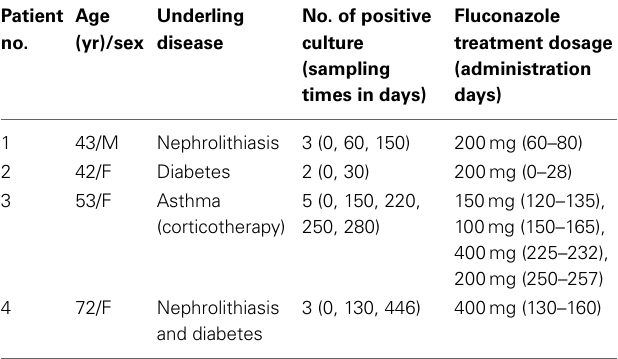
Table 3 | Characteristics and fluconazole treatment features in six patients infected with C. glabrata that acquired in vitro resistance under fluconazole